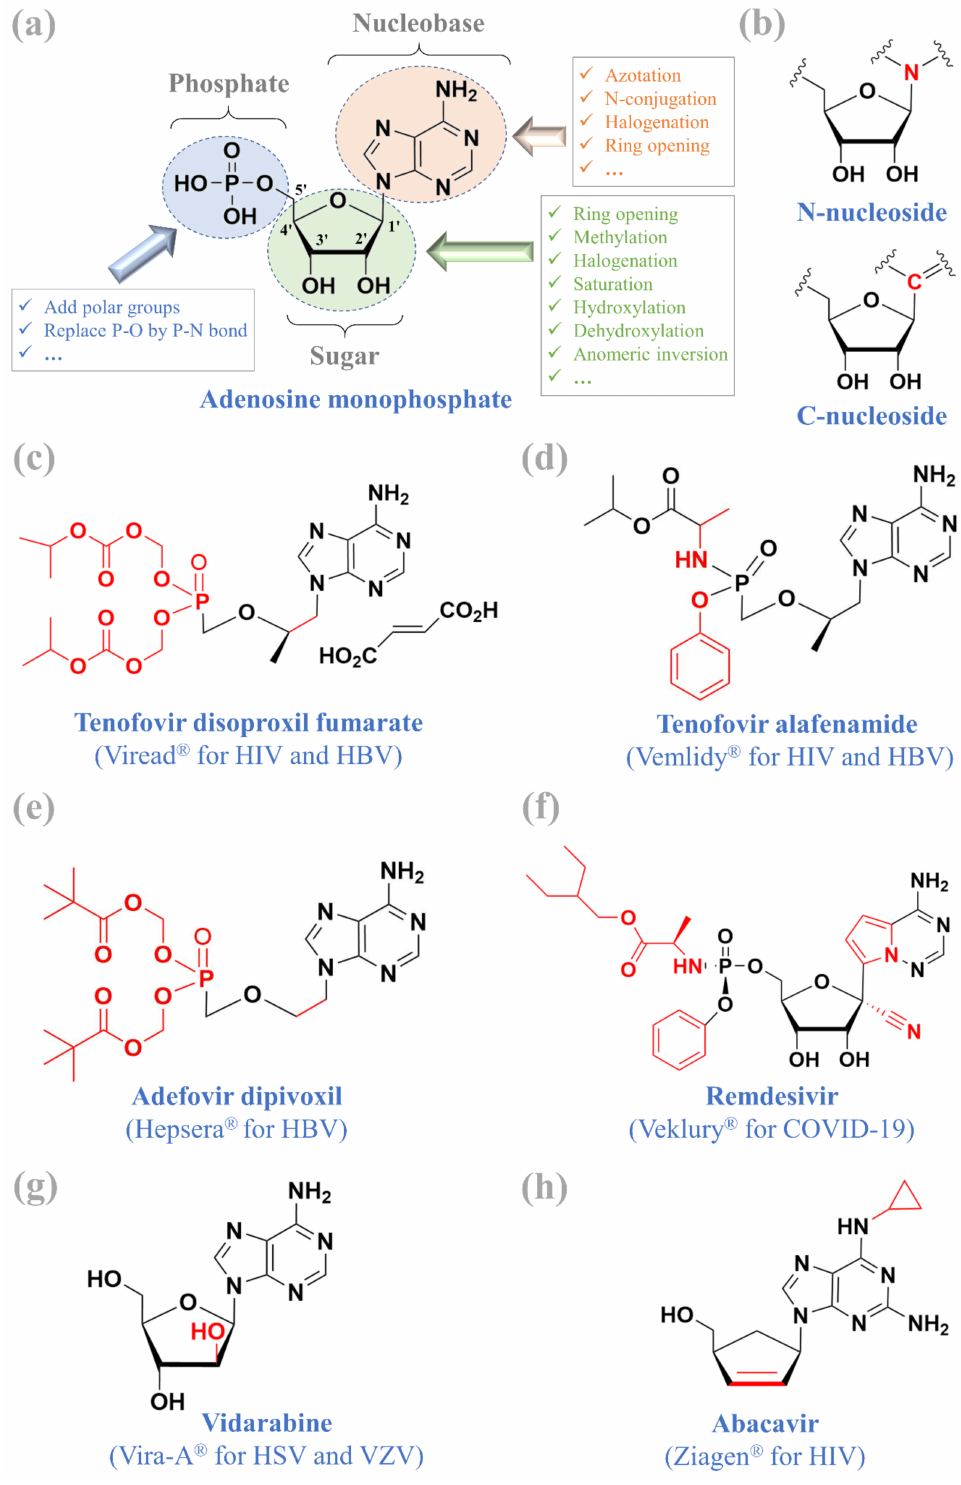
Figure 1. Adenosine monophosphate ( a ), N-nucleoside and C-nucleoside ( b ), and six approved adenosine nucleos(t)ide analogues ( c – h